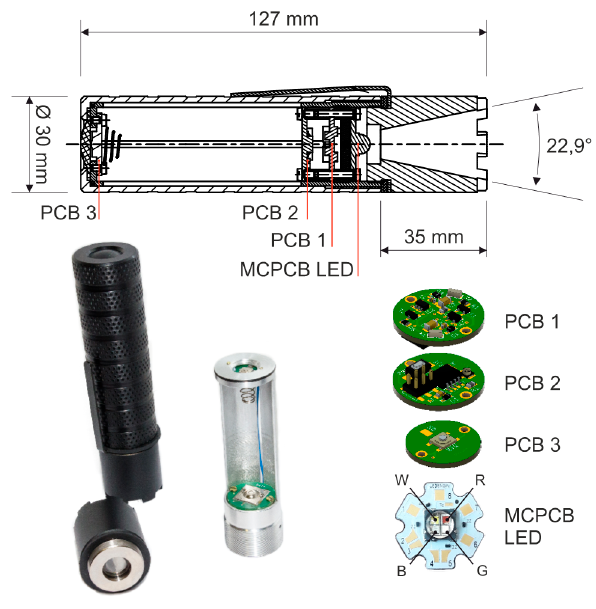
Figure 12. Implementation and printed circuit board design.